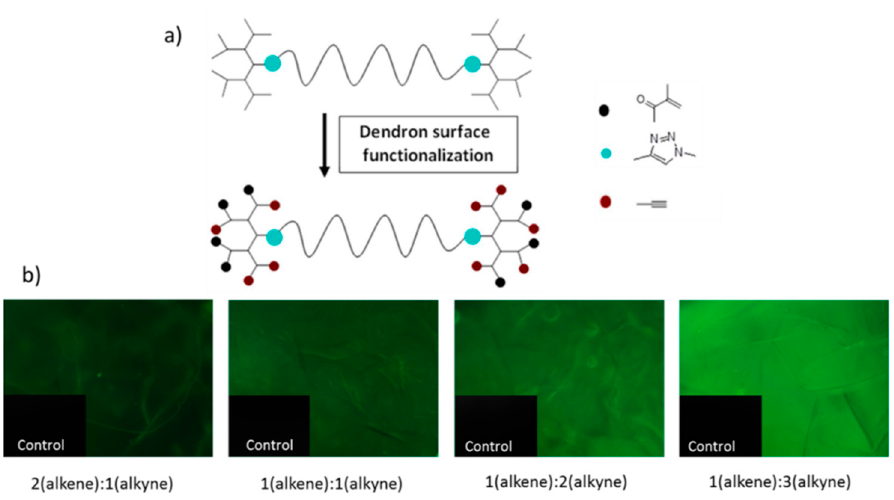
Figure 17. ( a ) Dendron surface modification; ( b ) fluorescent microscope images of obtained bulk hydrogels with different alkene/alkyne ratios after bio-immobilization with biotin azide and FITC-labeled streptavidin interaction. Adapted with permission from [45], Copyright © 2015 American Chemical Society.